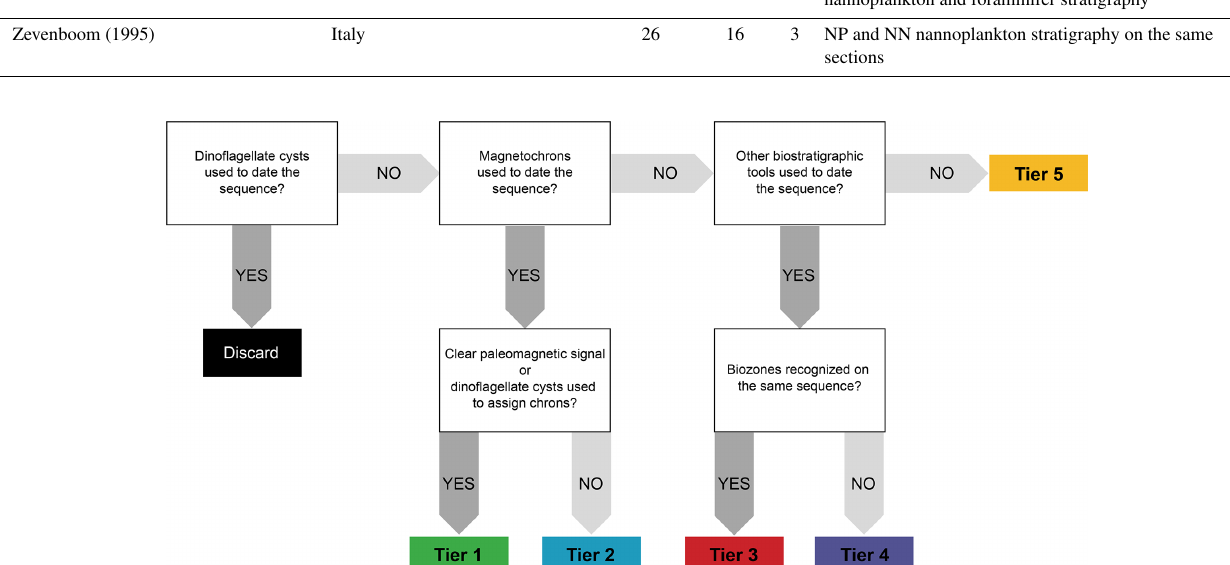
2021, for surface sediment station locations,